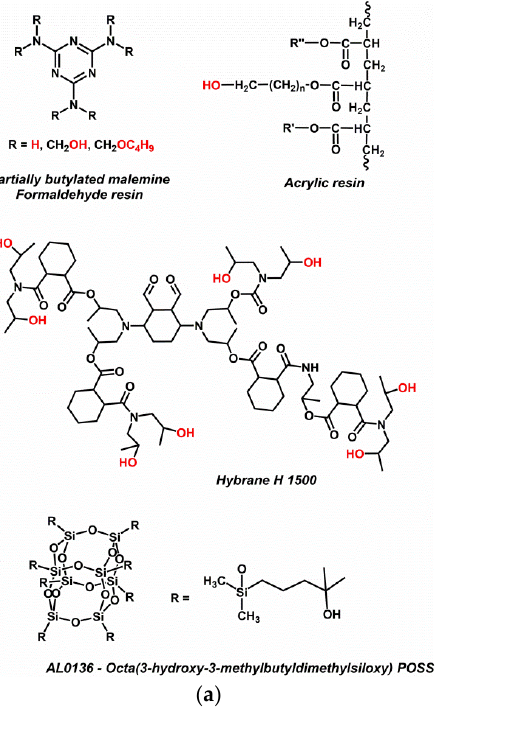
Figure 3. ( a ) Chemical structure of acrylic, melamine, HBP and POSS components used in clearcoat formulations; ( b ) Schematic illustration of enhanced healing in presence of HBP and POSS. Reproduced from RSC Adv . 2016, 6 , 76028 – 76041 [60] with permission from the Royal Society of Chemistry.